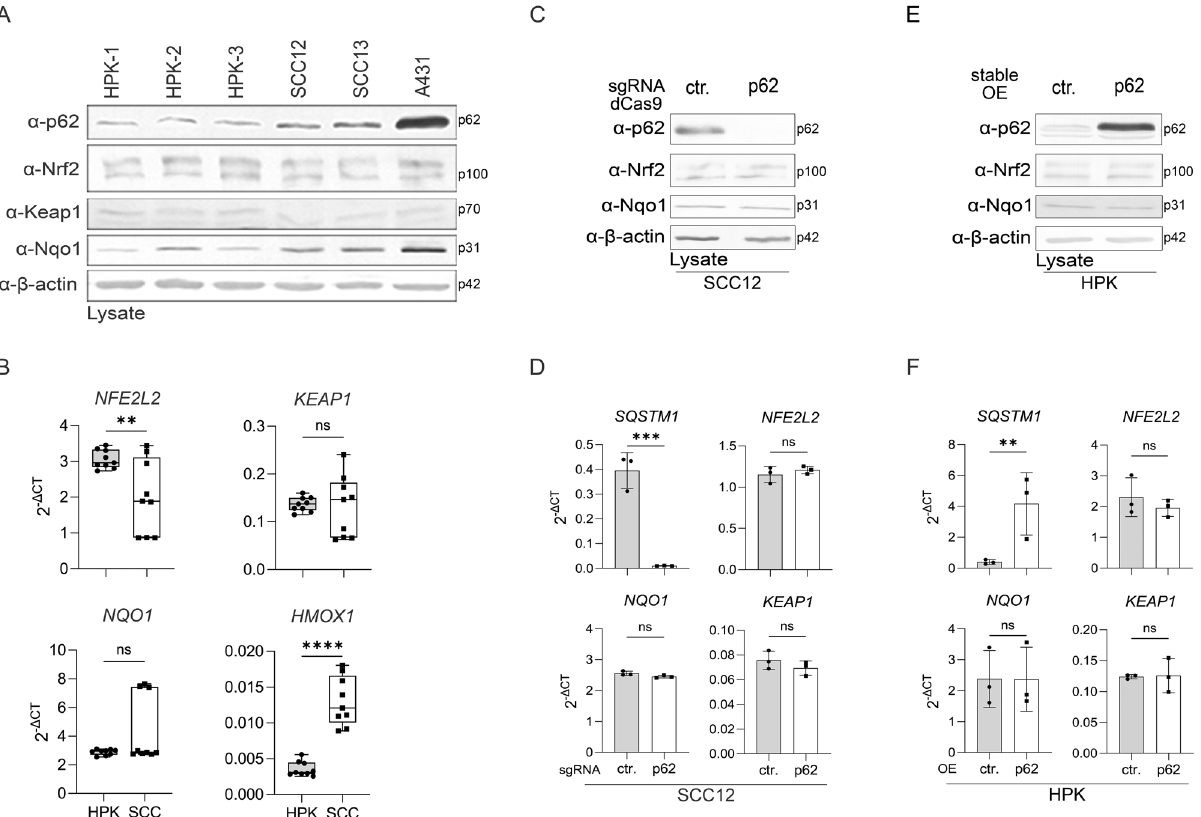
Fig. 4 The Nrf2 pathway is not a target of p62 in SCC cells. HPKs from three different donors and SCC cell lines were analyzed for expression of the indicated genes. ( A ) Western blots for protein expression and ( B ) qPCR for mRNA expression. Expression of the indicated genes in control and p62 knockout SCC12 cells. C Western blots for protein and D qPCR for mRNA expression. E , F Expression of the indicated genes in control and stable p62 overexpressing HPKs. E Protein expression by western blots and F qPCR for mRNA expression. Data are represented as mean ± SD of three experiments ( B , D , F ) or are representative of three ( A , C ) or two ( E ) independent experiments. B 3 donors in the group of HPKs ( N = 9) and 3 SCC cell lines (SCC12, SCC13, A431) in the group of SCCs ( N = 9) were subjected. P values were calculated with two-tailed unpaired ( B ) or paired ( N = 3) ( D , F ) t test. (**** P < 0.001, *** P ≤ 0.001, ** P ≤ 0.01, ns = not signi fi